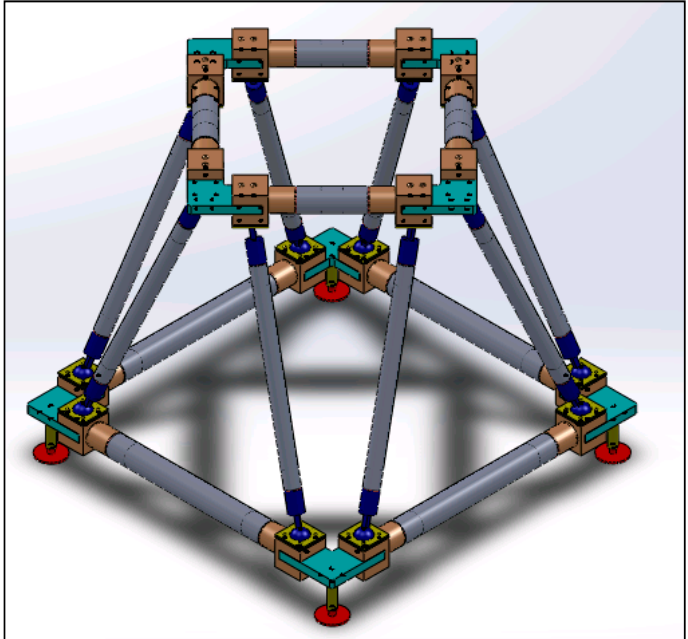
Figure 6. Concept of a lattice base with structural nodes alternative to the one shown in Figure 2.